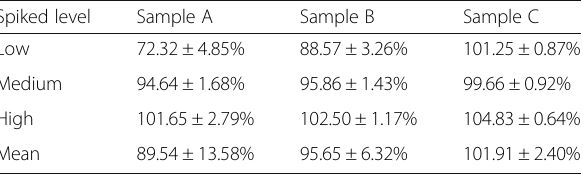
Table 2 Recovery of morphine from three different sample matrices over 3